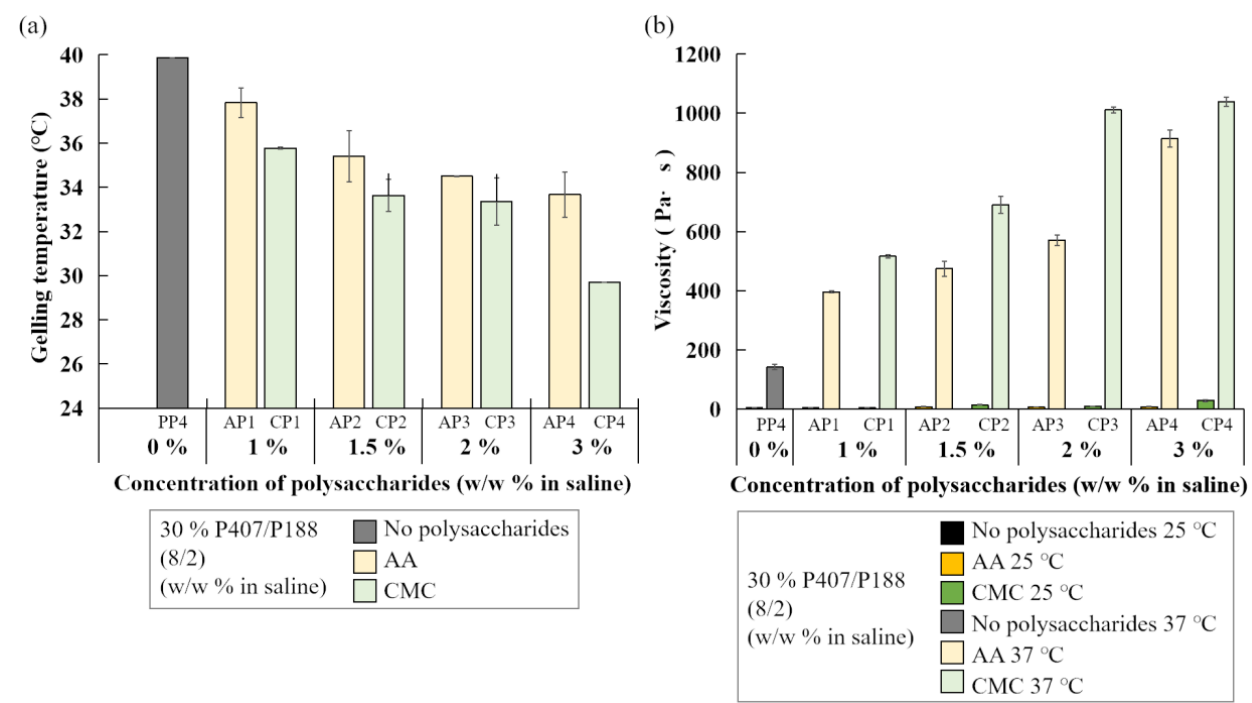
Figure 3. ( a ) Average gelling temperature and ( b ) average viscosity of P407/P188-blended hydrogels at 8/2 ratio without (gray bar) or with different concentrations of AA (yellow bars) or CMC (green bars). Table 4. Components in the formulation of P407-based hydrogel containing polysaccharides with different concentrations of poloxamers ( w / w % in 10 g